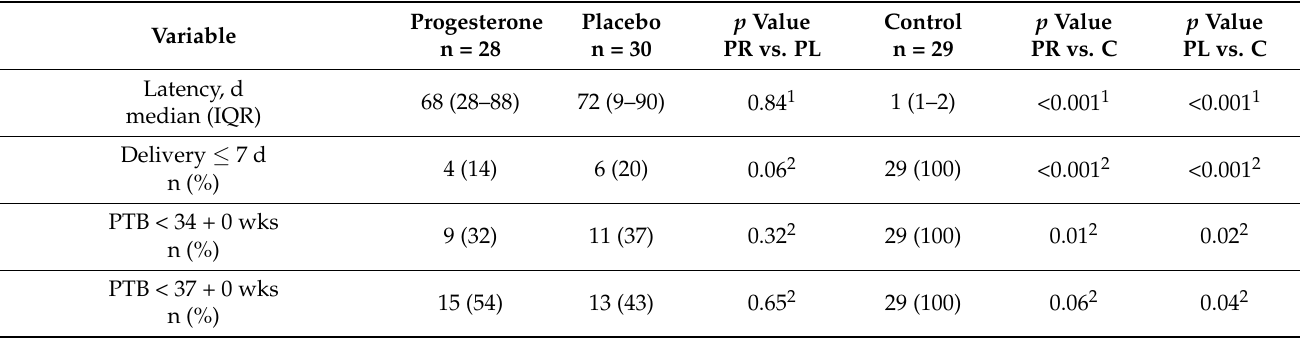
Table 2. Maternal outcome. Statistical methods: Mann–Whitney U-test, general linear model and one-way ANOVA 1 , and Chi 2 -test and Fisher’s exact test 2 .